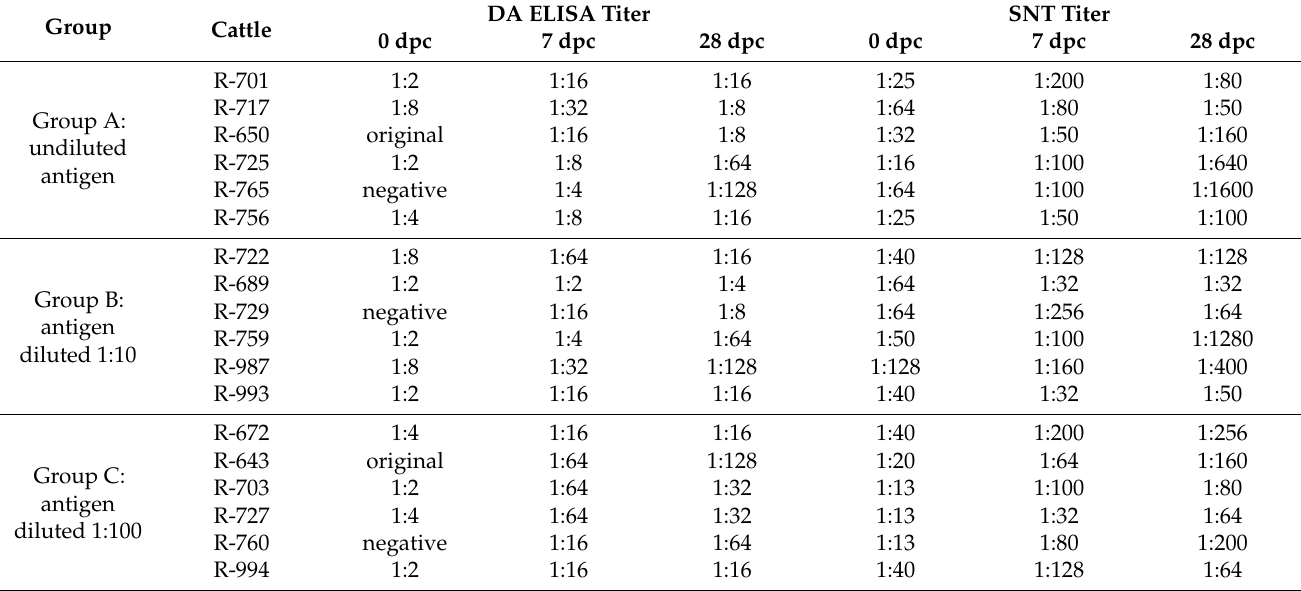
Table 2. Comparison of development of ELISA and SNT titers after